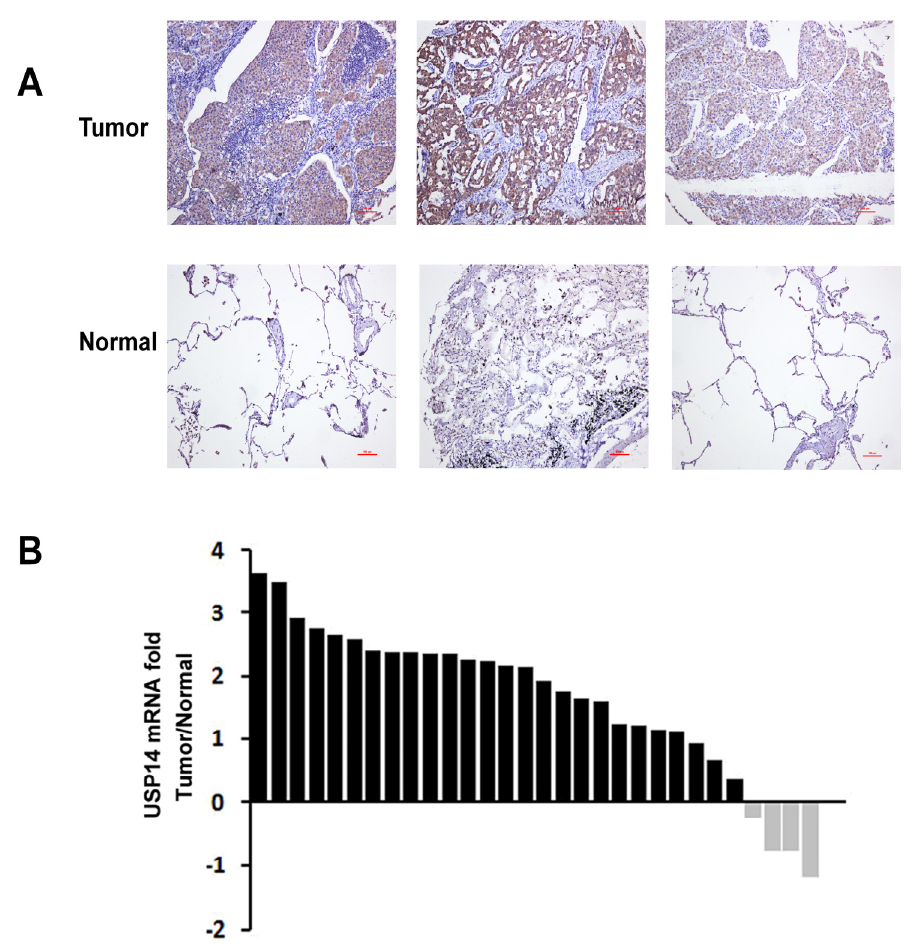
Figure 2. Expression of USP14 in NSCLC tumor tissues. ( A ) Representative images of USP14 immunohistochemistry staining in lung adenocarcinoma tissues and matched normal adjacent tissues. Red Bar, 100 μ m; ( B ) Real-time qPCR analysis of USP14 mRNA expression in 30 lung adenocarcinoma